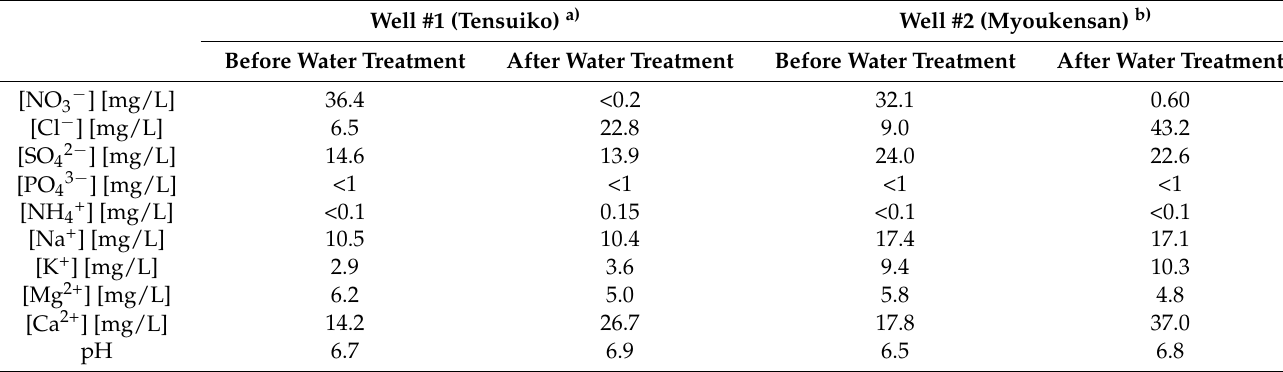
Table 1. Changes in water quality due to denitrification of